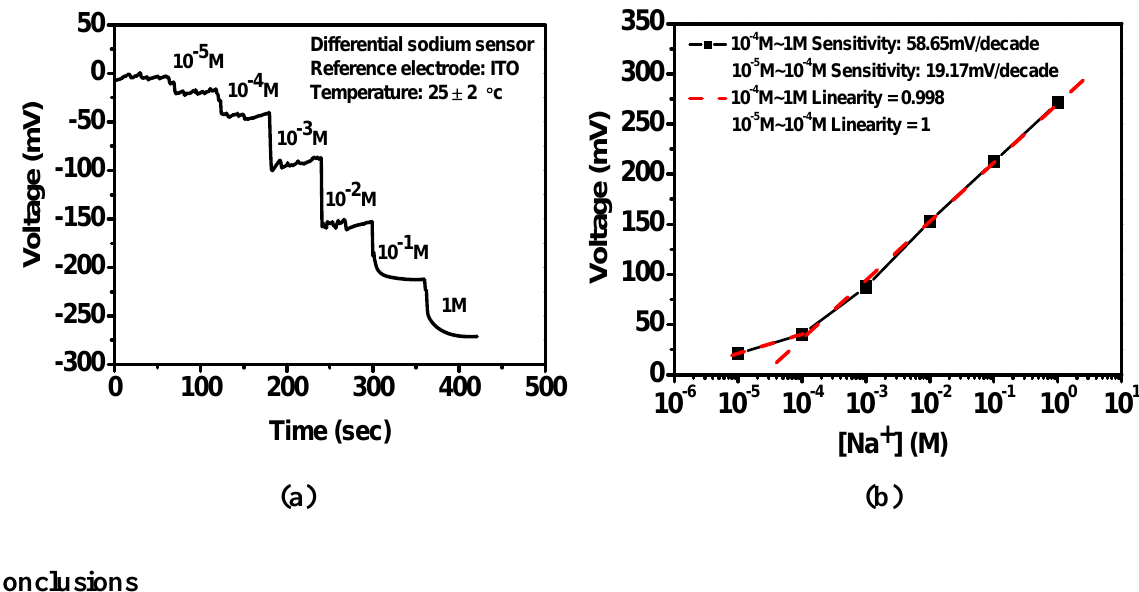
Figure 12. Differential sodium ion sensor based on anodized-ITO for (a) output response voltage vs. times with titration and (b) corresponding